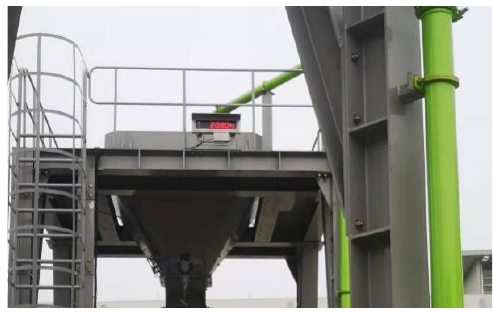
Figure 9. Concrete pumping test.